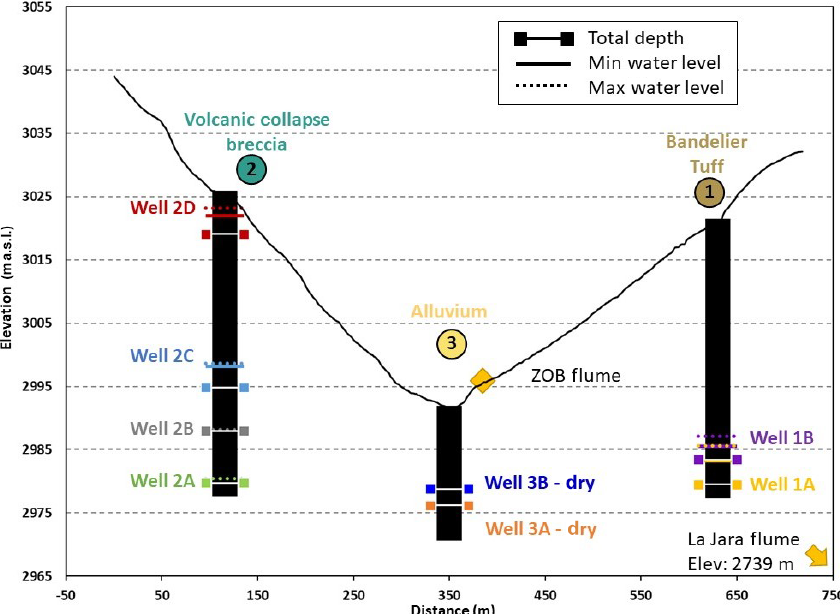
Figure 2. Profile of the nested groundwater wells within the ZOB showing the surface topography, depth of the wells, and seasonal changes in water column heights between their maximum (dotted) and minimum (solid) levels in meters above sea level. Lines capped with square ends represent the base of each well. It is important to note the different rock type at each site, the suspected presence of a perched aquifer at well 2D, the disconnection between the wells of sites 1 and 2 across the same elevation, as well as the absence of water in site 3